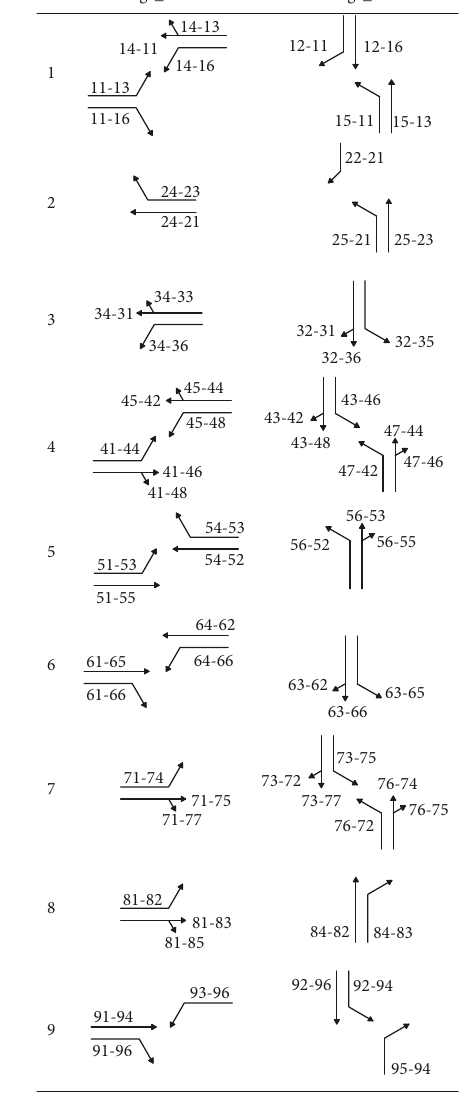
Figure 7: Stage plans for Test Network-2. Table 3: Link-related data for Test